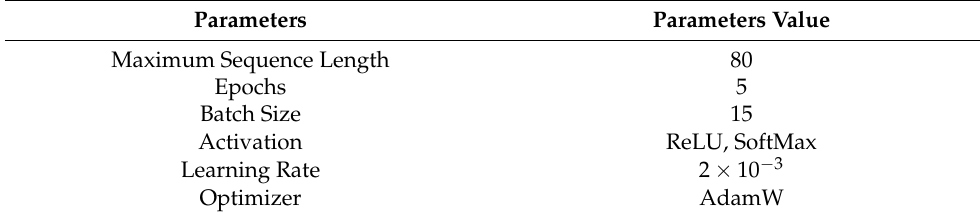
Table 3. Optimized hyperparameters adapted for